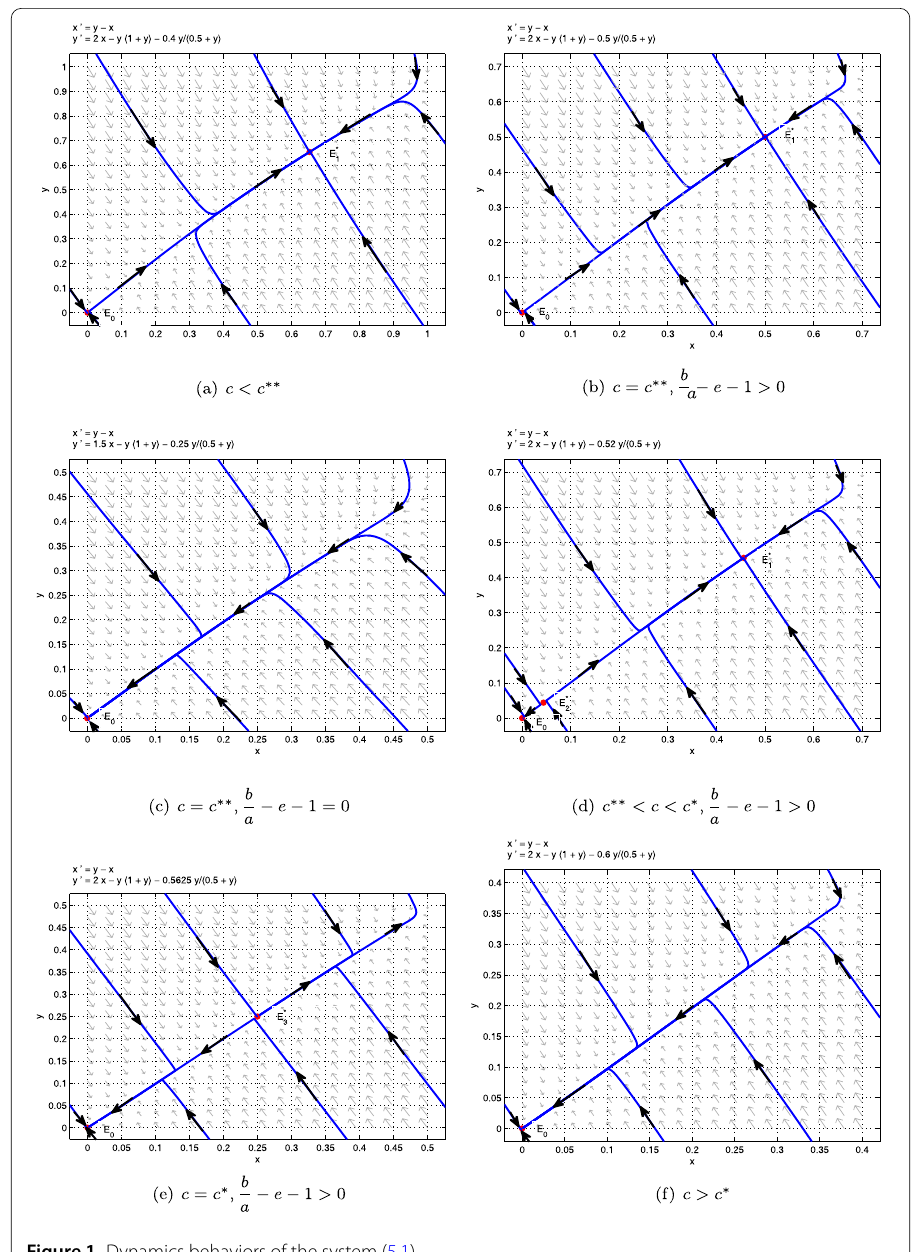
Figure 1 Dynamics behaviors of the system